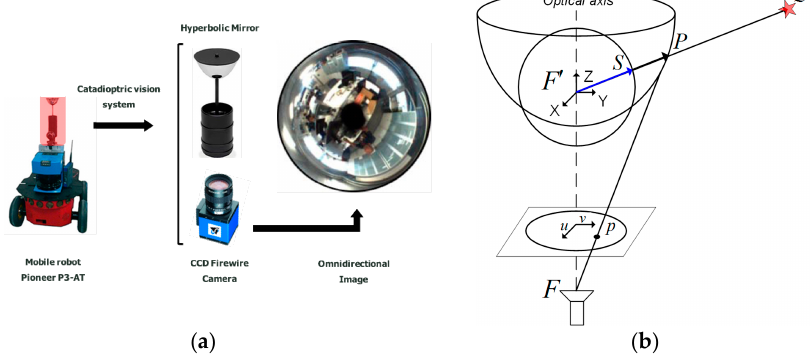
Figure 1. Real system: ( a ) Robot P3-AT with the catadioptric sensor (CCD camera and hyperbolic mirror); ( b ) Camera projection model